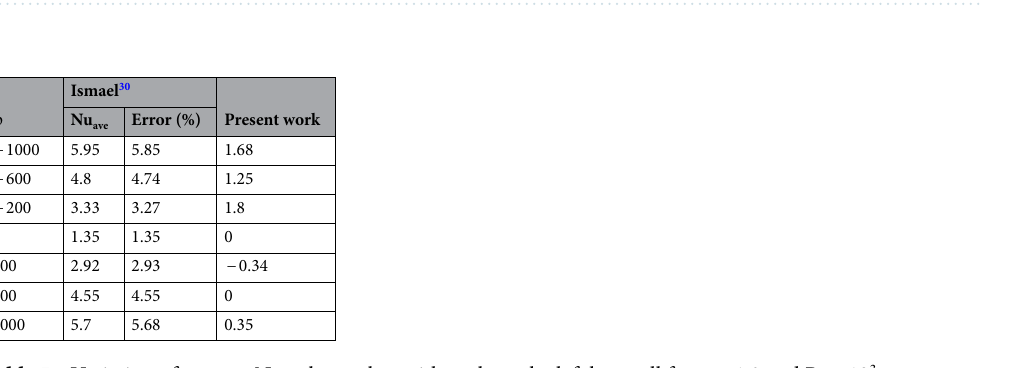
Table 5. Variation of average Nusselt number with ω along the left hot wall for x o = 1.3 and Ra = 10 3 .